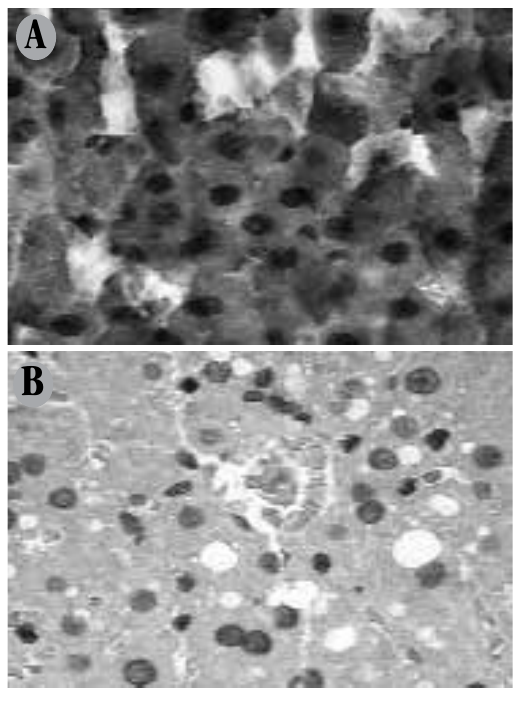
figurE 3 – Pattern of cytoplasmic immunostaining for liver adiponectin A) strong and diffuse in animals of the control group (400×); B) low positivity in the high-fat diet associated to steatosis areas (400×).